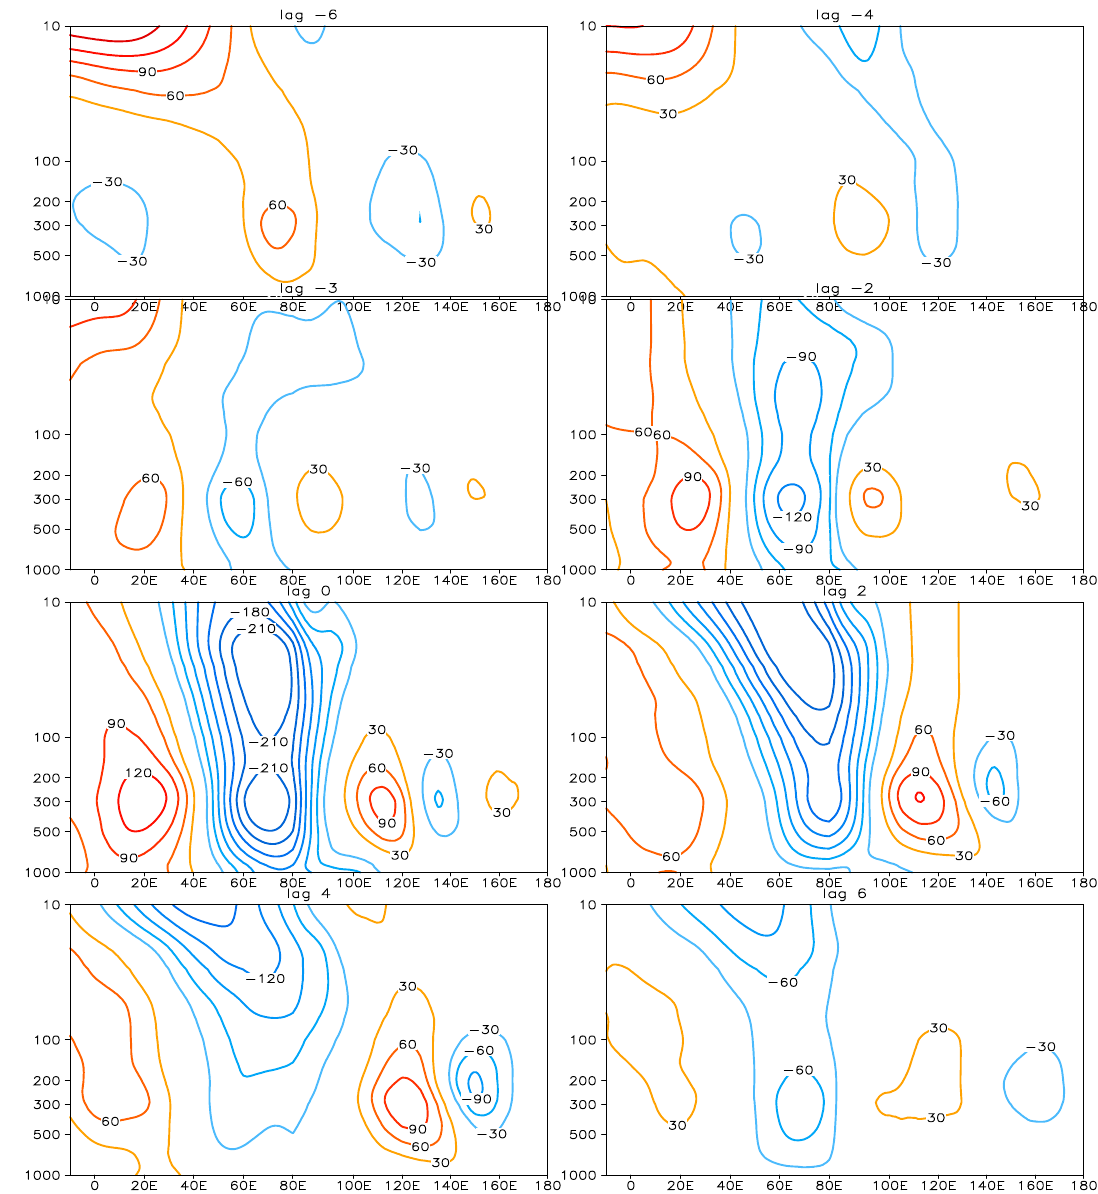
Figure 13. Vertical cross sections of the geopotential height anomaly along the center of each anomaly for the negative EU phase at a lag of − 6 days, − 4 days, − 3 days, − 2 days, 0 days, 2 days, 4 days, and 6 days, respectively.